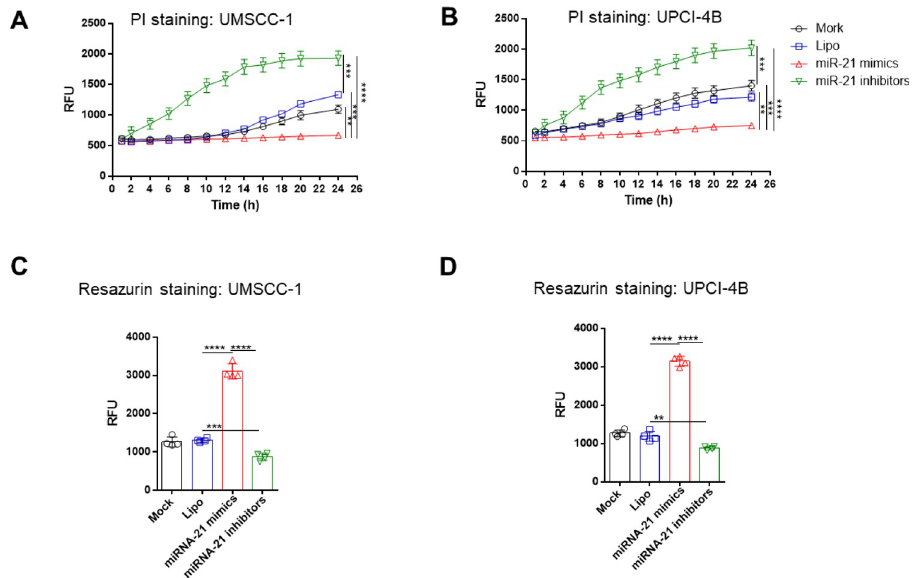
Fig 4. miR-21 can reduce apoptosis and enhance cell viability. (A) and (B) Apoptosis evaluation with Cell Apoptosis PI Detection assays showed that the miR-21 mimic significantly decreased apoptosis, while the miR-21 inhibitor increased cell apoptosis in both the UMSCC-1 and UPCI-4B cell lines, respectively. (C) and (D) Cell viability assessment with resazurin cell viability assays showed that the miR-21 mimic group had significantly more viable cells than the miR-21 inhibitor group in both the UMSCC-1 and UPCI-4B cell lines. �� , P < 0.01; ��� , P < 0.001; ���� , P < 0.0001.